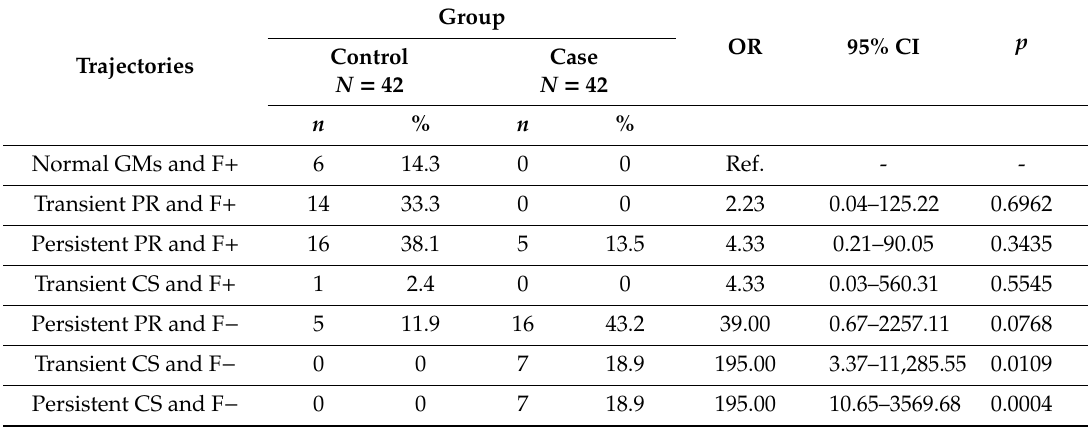
Table 4. General Movements (GMs) trajectories associated with Cerebral Palsy.